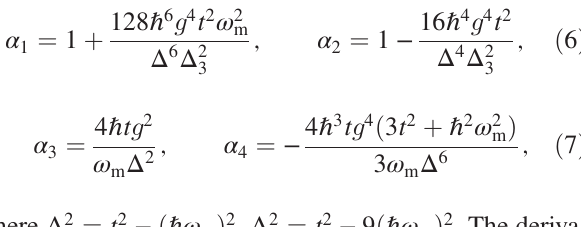
FIG. 5. Wave functions of the two qubit states j 0 i (upper panels) and j 1 i (lower panels) for t= ℏ ω x Þ (yellow), h σ x Þ (green), and ψ x Þ 2 þ ψ x Þ 2 (blue). Note that for small coupling, the yellow and blue lines perfectly plot − h σ x ið z ið n þ ð n − ð overlap. The probability of occupation of the first single-harmonic oscillator states is indicated in the